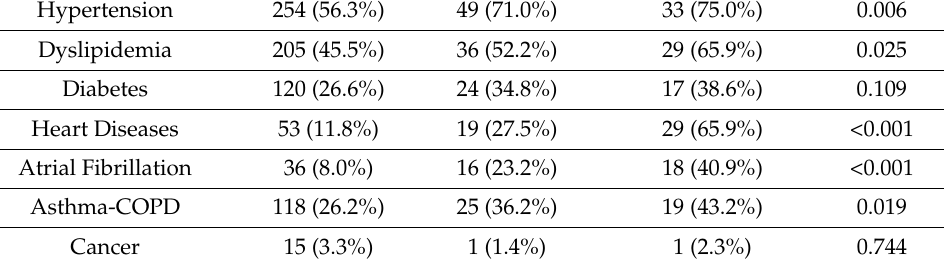
Table 4. Bivariate analysis of variables associated with the levels of stroke severity.